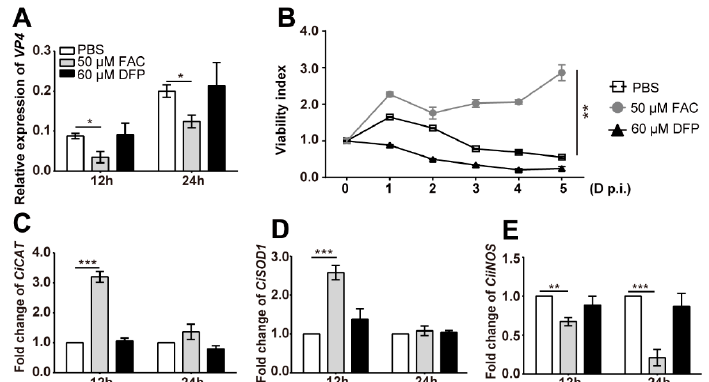
Figure 8. Iron reduces the load of GCRV, enhances oxidative stress in CIK cells, and improves cell survival. CIK cells were seeded into 12-well (1 × 10 6 / well) ( A , C , D ) or 96-well plates (1 × 10 4 / well) ( B ), respectively, for 24 h cultivation, and then infected with GCRV (MOI = 1). Simultaneously, PBS, FAC (final concentration is 50 μ M), and DFP (final concentration is 60 μ M) were added into the corresponding wells. At the indicated time points, cells were harvested for RNA isola4040tion, and then the relative expression levels of VP4 ( A ), CiCAT ( C ), CiSOD1 ( D ), and CiiNOS ( E ) were detected. Data are presented in relative expression units where EF1 α was used to normalize all samples. At the indicated days, the viability index of each well was measured by using the MTT method ( B ). Data represent mean ± SD of three independent experiments. * p < 0.05, ** p < 0.01, *** p < 0.001. Int. J. Mol. Sci. 2018 , 19 , x FOR PEER REVIEW